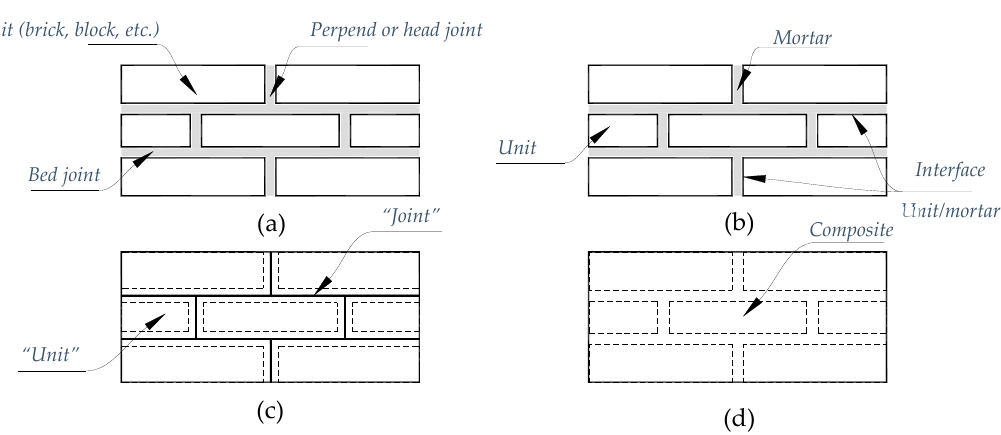
Figure 5. Modelling strategies at material level: ( a ) masonry sample; ( b ) detailed micromodelling; ( c ) simplified micromodelling; and ( d ) macromodelling, adapted from Lourenço [32].